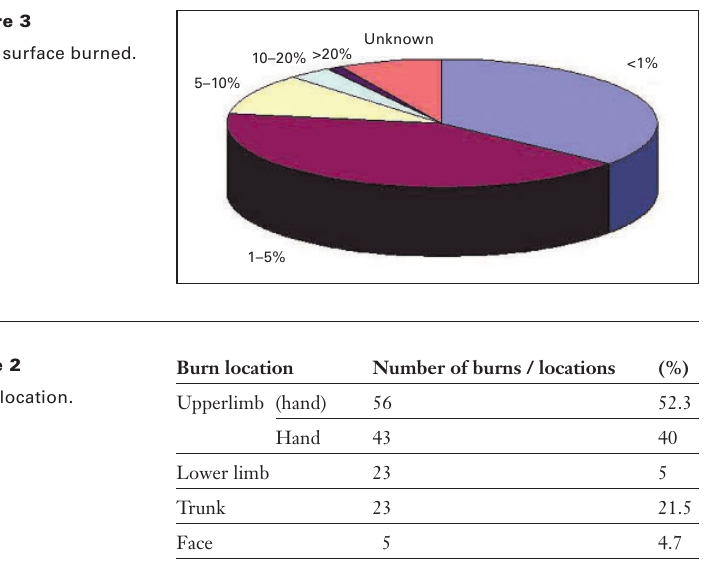
11 patients had burns at multiple locations: 8 patients with 2 locations, 3 patients with 3 locations and 1 patient with 4 locations.